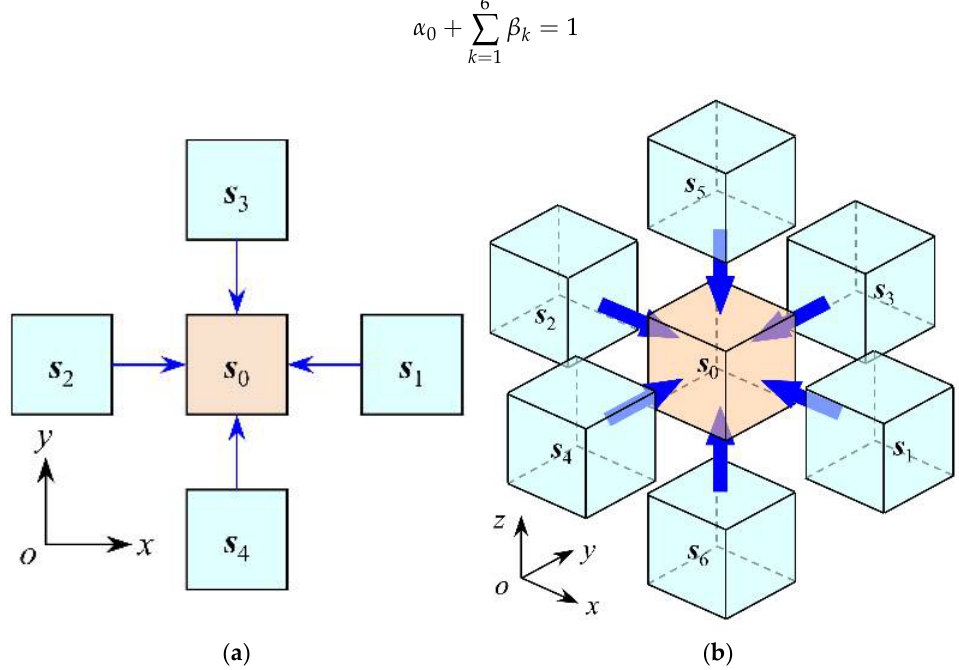
Figure 2. Type of neighborhood for 2D and 3D cellular automata. ( a ) Two-dimensional; ( b ) Three- Figure 2. Typeofneighborhoodfor2Dand3Dcellularautomata. ( a )Two-dimensional;( b ) dimensional.